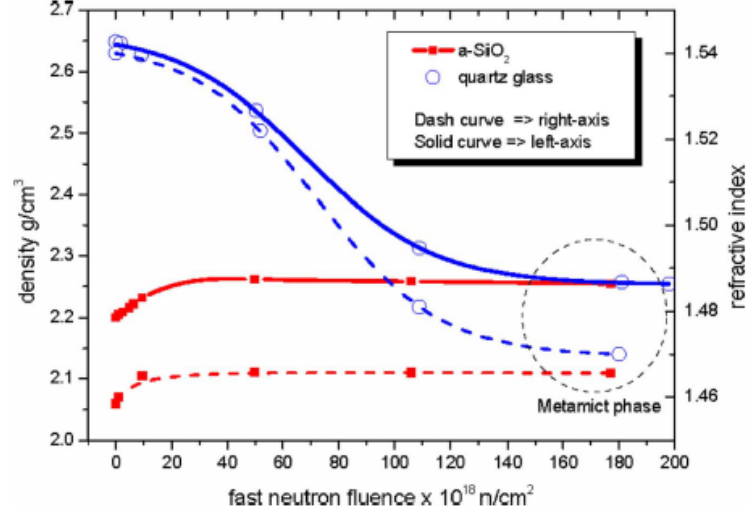
Figure 13. Density–refractive index relationship due to fast neutron radiation by [103] and adapted from [106].